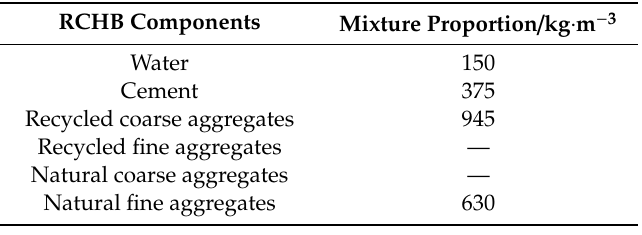
Figure 1. Aggregate components.